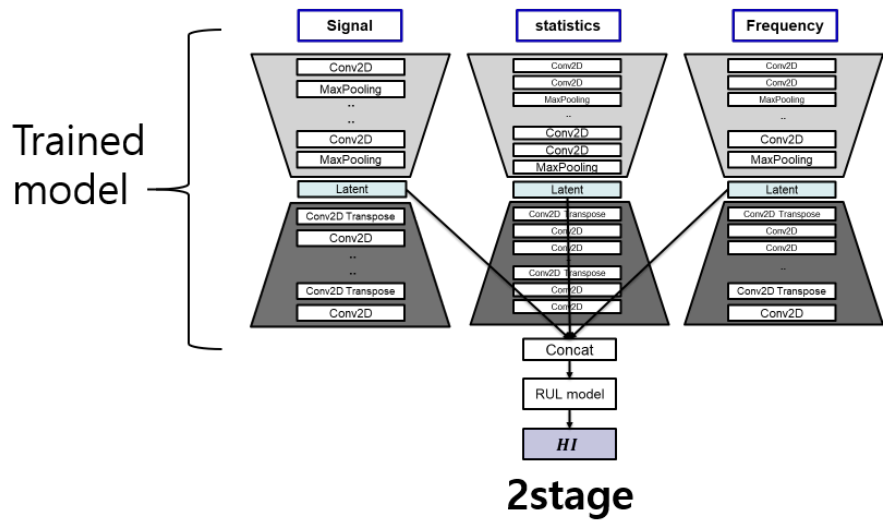
Figure 13. Network models of two-stage